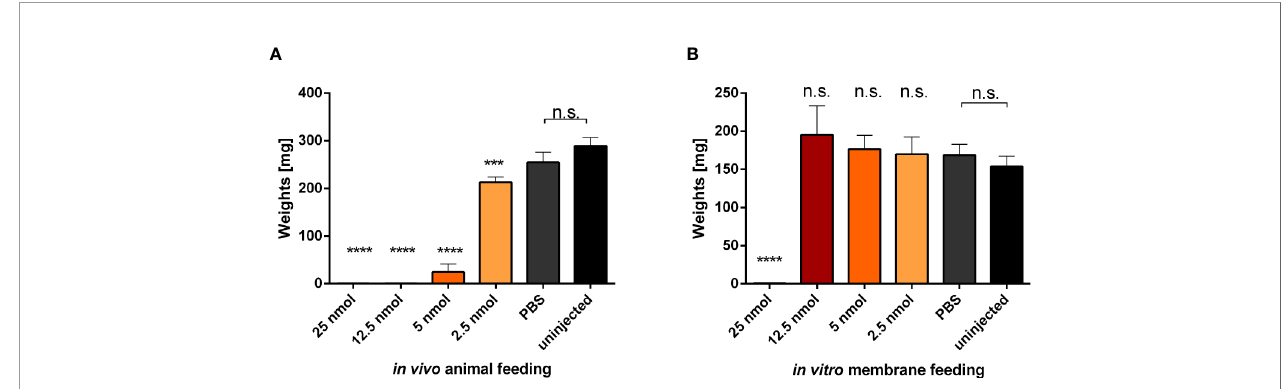
FIGURE 4 | Evaluation of micro-injected phosphoramidon effect on tick feeding. Adult I. ricinus females were micro-injected indicated amounts of phosphoramidon solubilized in PBS. (A) Weights of engorged females fed on a rabbit. Bars represent the mean and SEM, n ≥ 25. (B) Weights of engorged females fed on an arti fi cial membrane system. Data were obtained from two independent experiments. Bars represent a mean and SEM, n ≥ 12. Asterisks indicate statistical signi fi cance, *** indicate p = 0.0003, **** indicate p < 0.0001, n.s, not signi fi cant, when compared to the uninjected control.